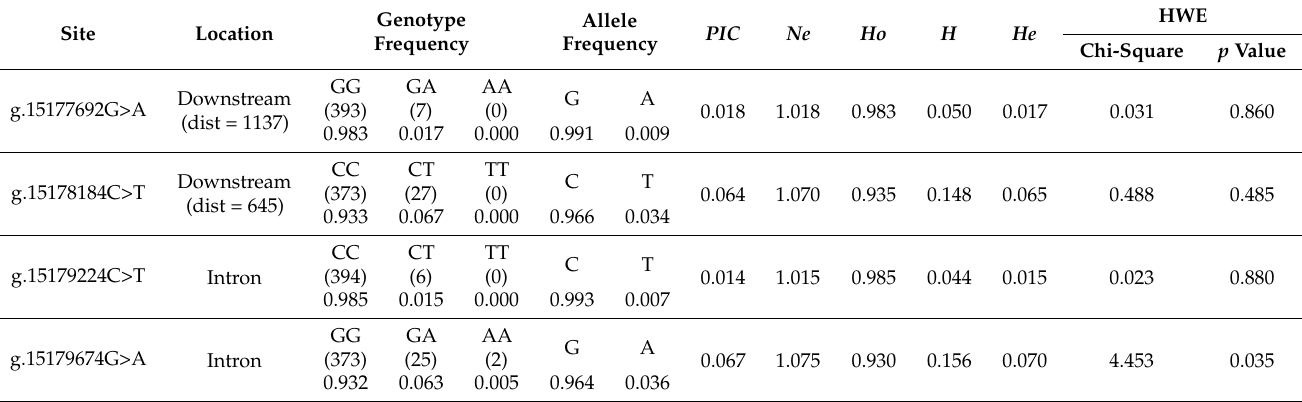
Table 3. Population genetic analysis of 4 SNPs of the HOXC8 mutation in Dezhou